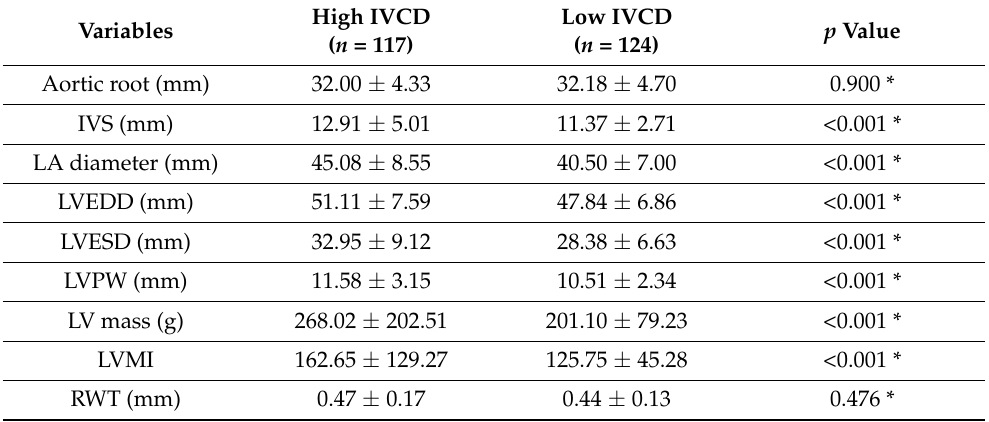
Table 2. Echocardiographic features of chronic hemodialysis (HD) patients with functional arteriove- nous access (AVA) between high- and low-IVCD groups. IVCD, inferior vena cava diameter. High Variables